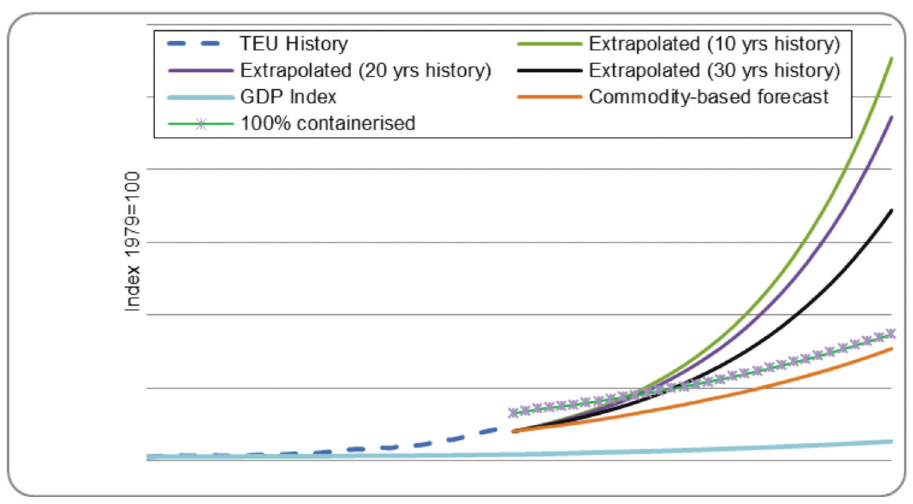
Figure 5: Extrapolated container versus commodity-based forecast with ceiling container volumes